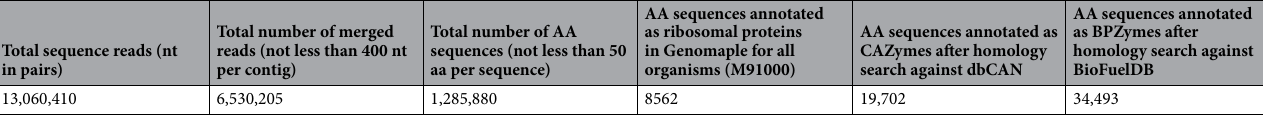
Table 2. Basic sequence information on emao metagenome data. The nucleotide sequences were obtained after shot-gun sequencing of the six-pooled sample of emao in Illumina HiSeq 2500 Platform. CAZymes carbohydrate-active enzymes, BPZymes biofuel producing enzymes.